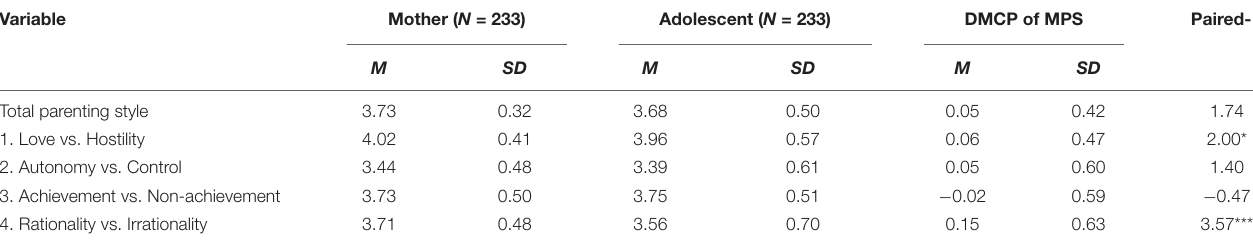
TABLE 1 | Differences between mothers’ and children’s perceptions of mothers’ parenting styles. Variable Mother ( N = 233) Adolescent ( N = 233) DMCP of MPS Paired- t